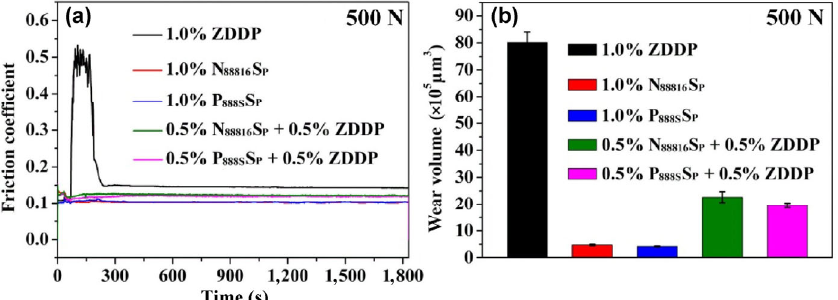
Fig. 10 Friction-reducing and anti-wear properties of ZDDP, N 88816 S P , and P 888S S P at mass concentrations, namely, 1.0 wt% ZDDP, 1.0 wt% N 88816 S P , 1.0 wt% P 888S S P , 0.5 wt% N 88816 S P + 0.5 wt% ZDDP, and 0.5 wt% P 888S S P + 0.5 wt% ZDDP for steel/steel contacts at 500 N, 25 Hz, and